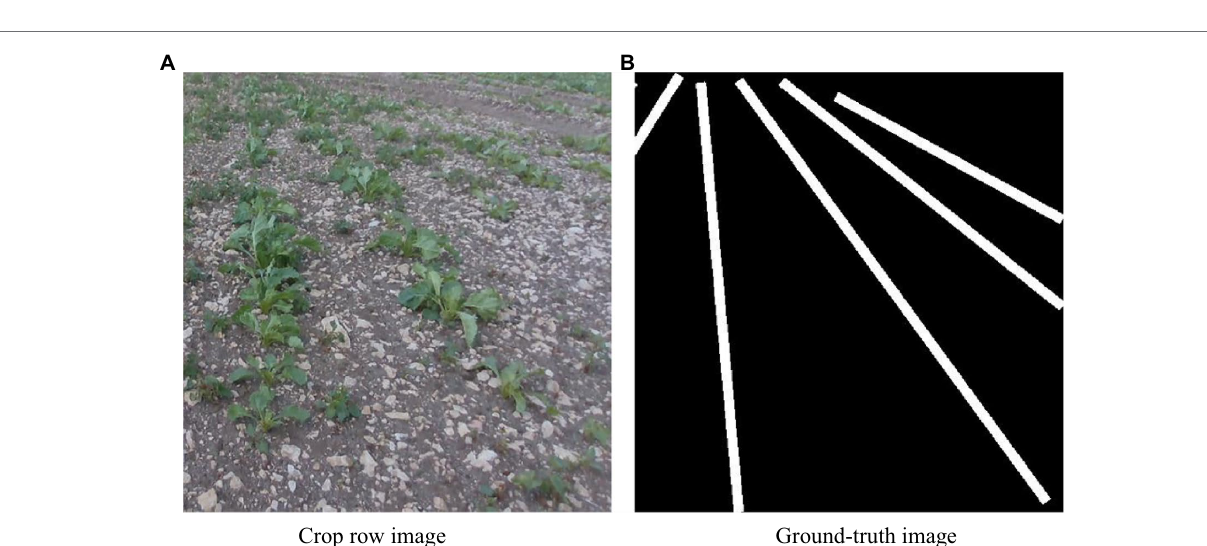
FIGURE 6 | Sample crop row images and their corresponding ground-truth images.